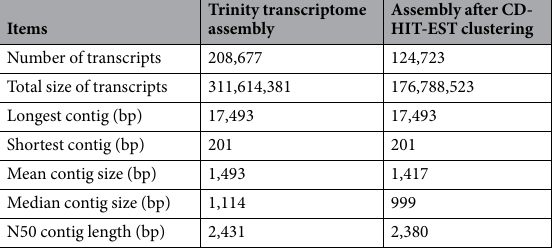
Table 1. Overview of sequencing outputs and assembly of Capparis spinosa leaf